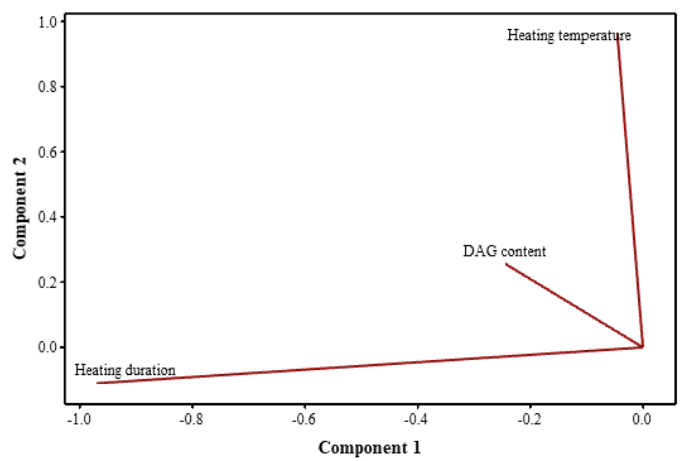
Figure 3. The loadings plot of the PLS model.